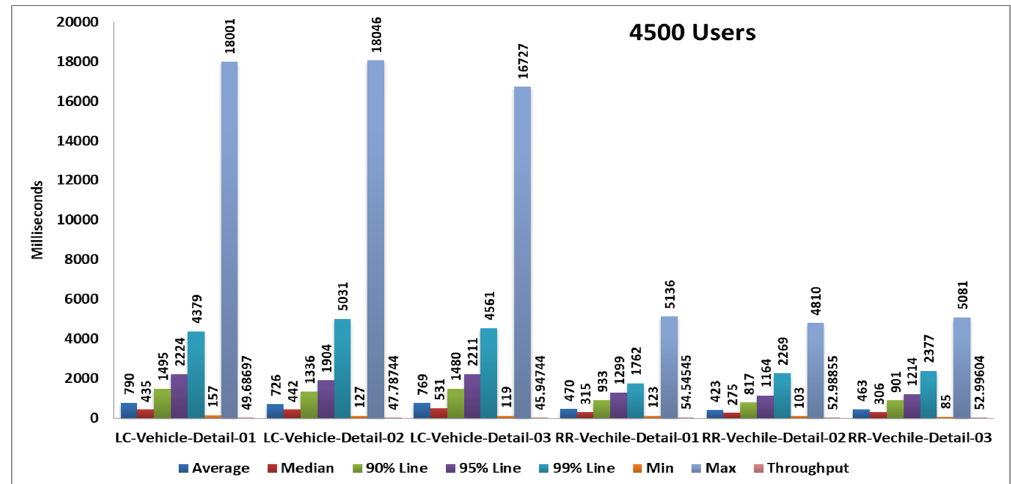
Figure 16. Aggregate graph using Table 5 data. It shows the average response time, median, 90%, 95%, 99%, min & max parameters of the combined graph of the RR and LC algorithms of Table 4.